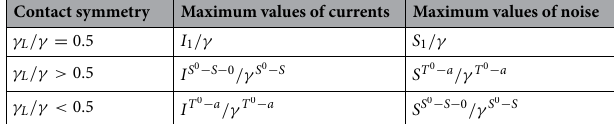
Contact symmetry Maximum values of currents Maximum values of